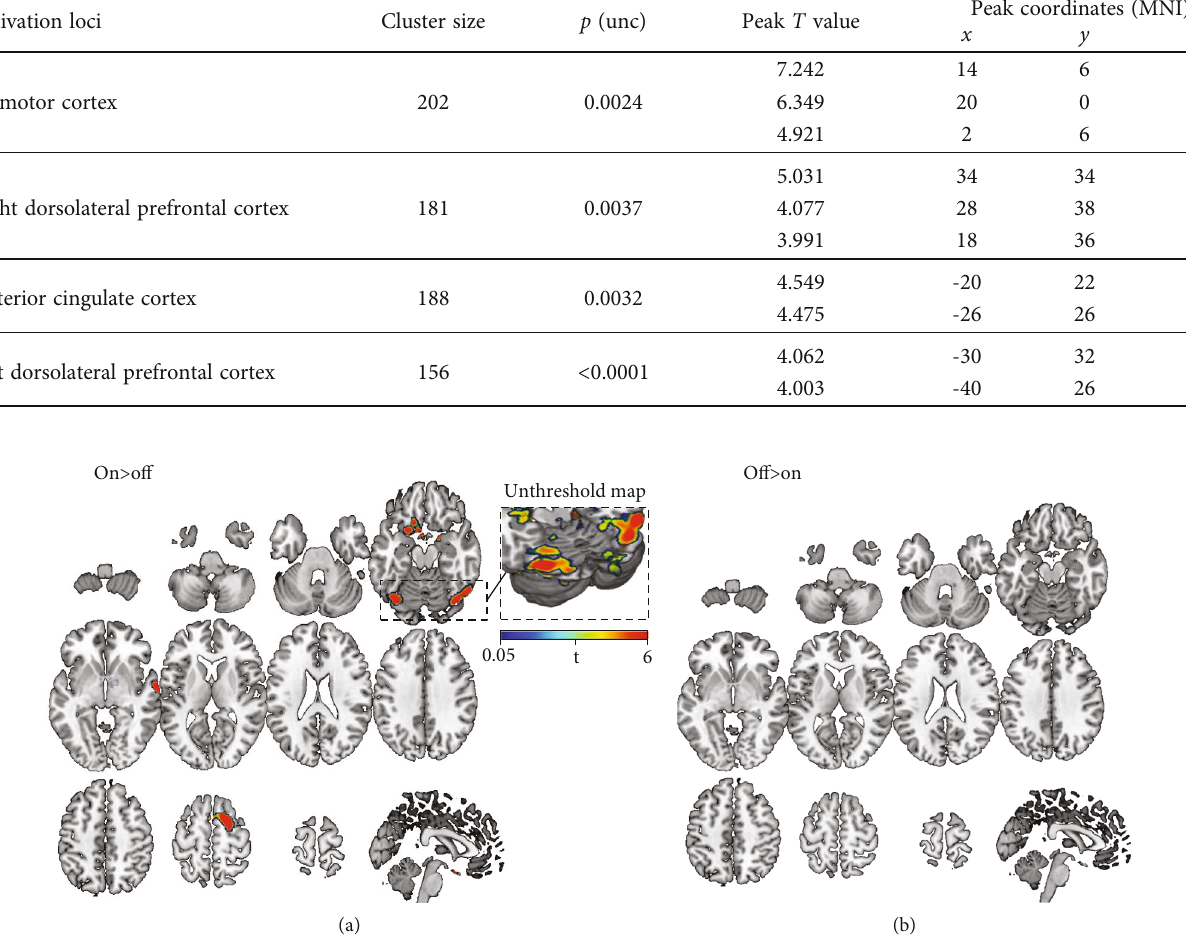
Figure 3: O ff -target e ff ect of tACS. (a) Signi fi cant BOLD changes that resulted from the whole brain analysis are shown in visual cortices, subgenual cortex, right temporal cortex, and SMA. (b) No signi fi cant results are shown in the absence of tACS ( off > on ). The results are masked for grey matter. More details on brain activation peaks are reported on Table 2. Images are presented in neurological convention (i.e., right brain is right in the fi